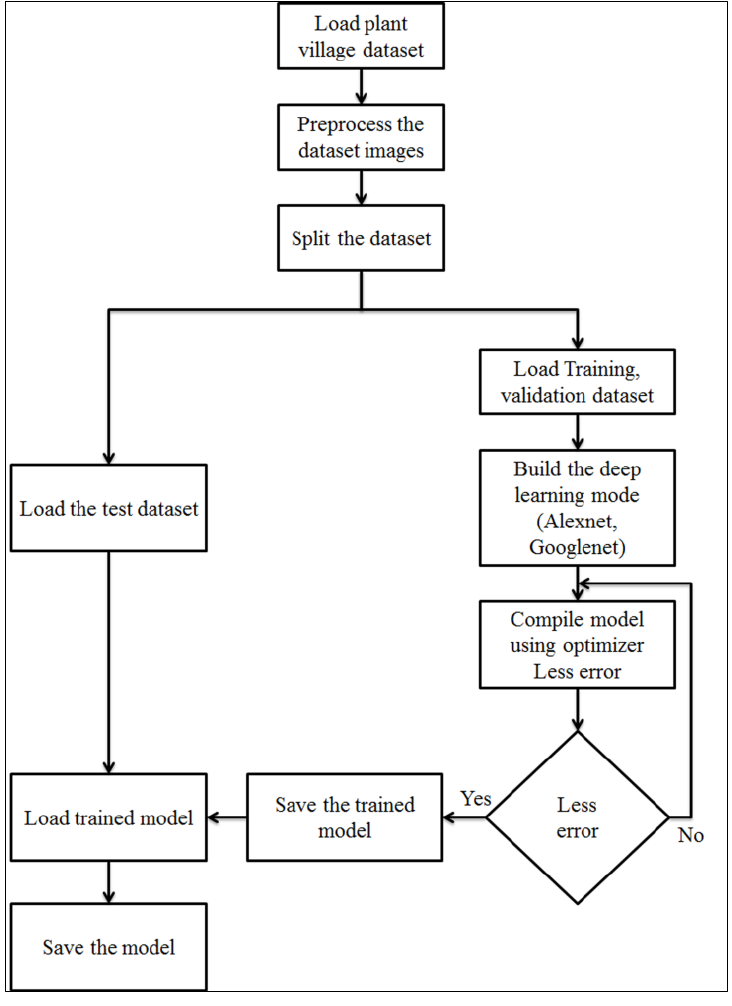
Figure 4: Experimental model